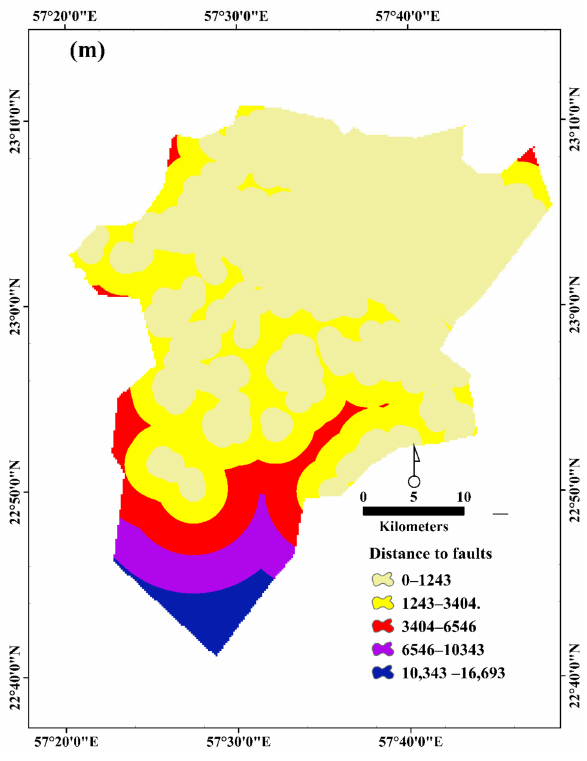
Figure 2. Illustrate different thematic maps ( a ) elevation, ( b ) TWI, ( c ) slope, ( d ) drainage density ( e ) geology map, ( f ) lineament density ( g ) soil types ( h ) plan curvature, ( i ) profile curvature ( j ) LULC, ( k ) rainfall, ( l ) slope aspect, and ( m ) distance to